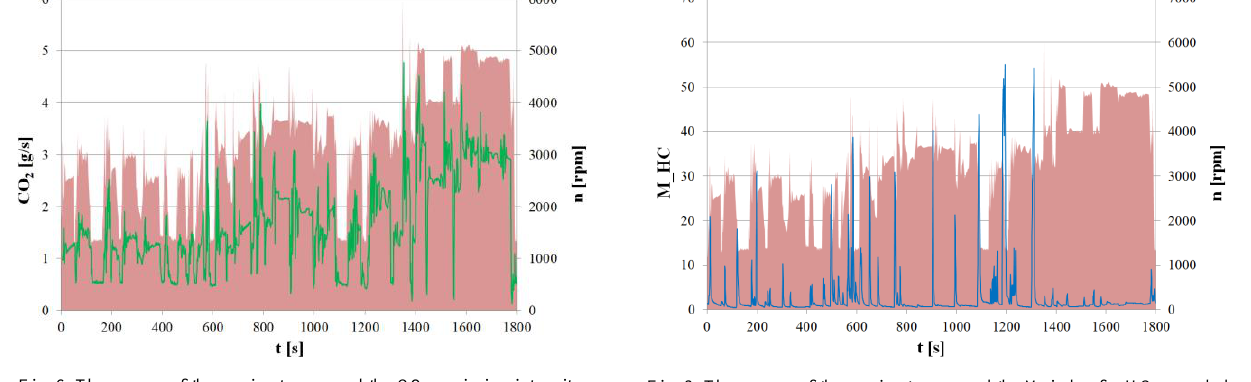
Fig. 8. The course of the engine torque and the M index for HC recorded during the tests in the WMTC test The analyzed index M in the cases considered so far is